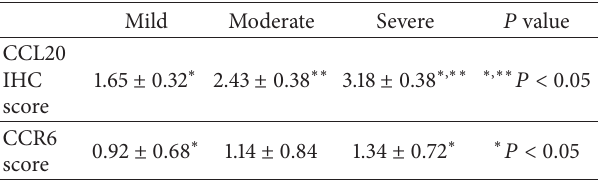
Table 2: The relationship between pathological inflammation sever- ity and CCL20 and CCR6 expression.